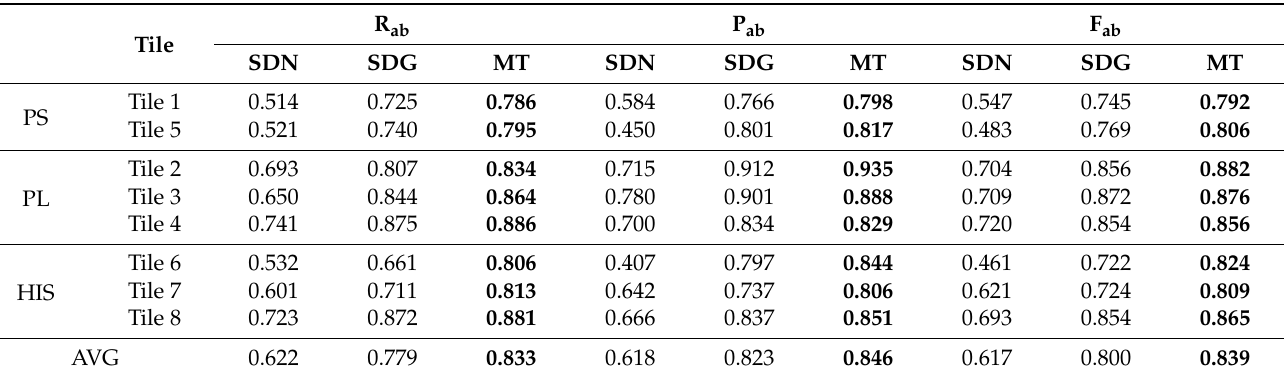
Table 5. The area-based accuracy evaluation results obtained using object-based classification with multi-temporal (MT) information, single-date observation in the growing season (SDG) information, and single-date observation in the nongrowing season (SDN) information. “AVG” represents the average value of the eight test tiles. The bold numbers in the table denote the accuracy of the classification strategy adopted in this